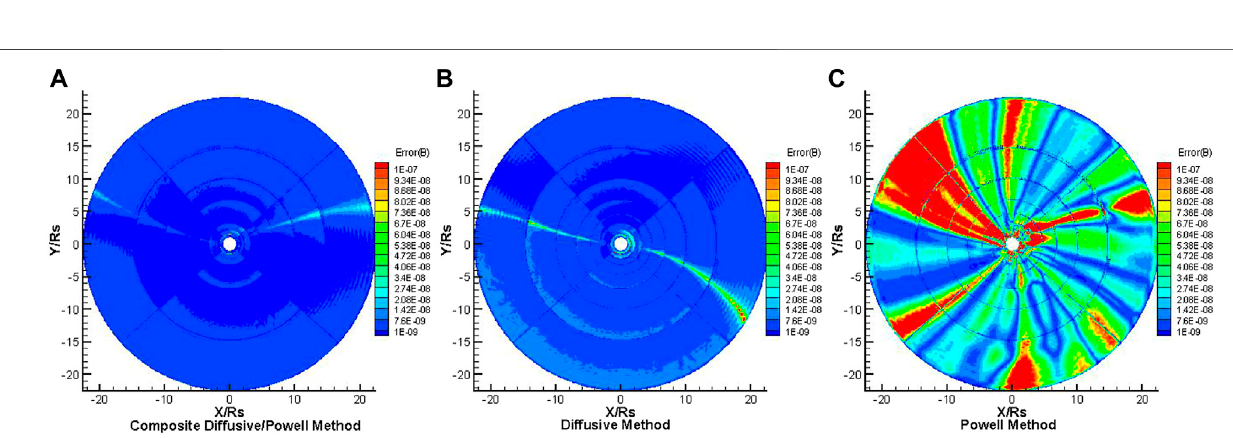
Frontiers in Physics |